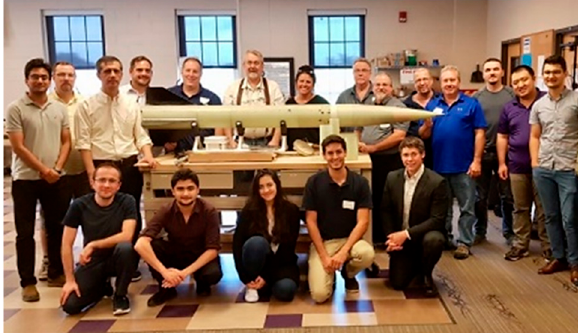
Figure 7. Attendees of the Summer 2019 Additive Manufacturing Studio Workshop .